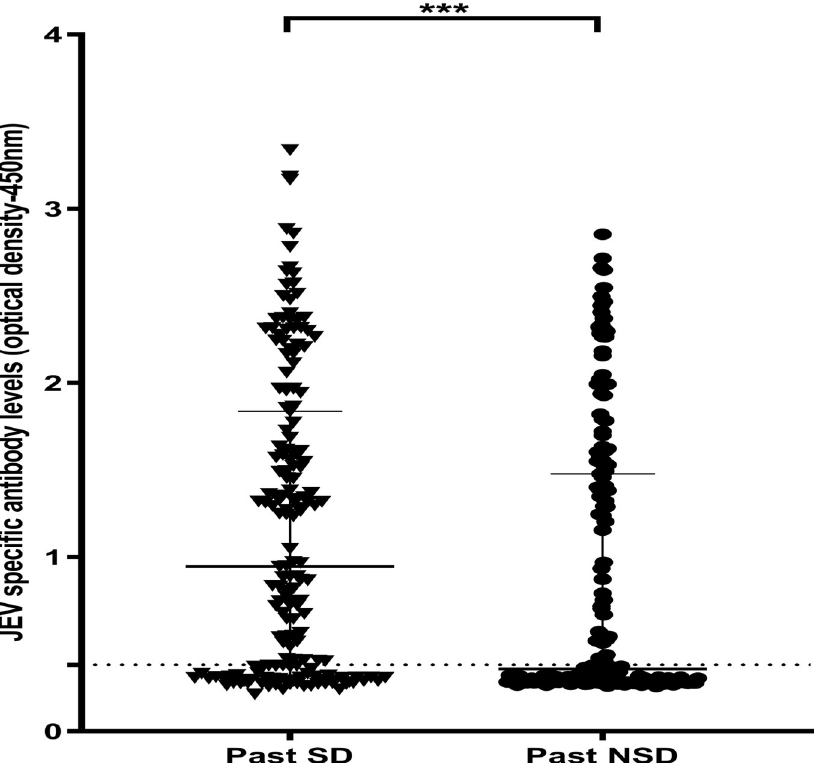
Fig 3. Antibody levels to JEV-specific pool of peptides in individuals who have had past NSD and SD. JEV-specific antibody responses were measured by ELISA to the JEV pool of peptides in those who have had NSD (n = 175) and SD (n = 175). Error bars indicate the median and the interquartile range. The horizontal dotted line represents the cut-off value of 0.382, which was considered as the mean, ± 3SD of the optical density of antibody levels in JEV - and DENV - seronegative individuals. Differences in the values of IgG antibody responses to JEV-specific peptides in individuals with SD and NSD were compared using the Mann-Whitney U test (two tailed).